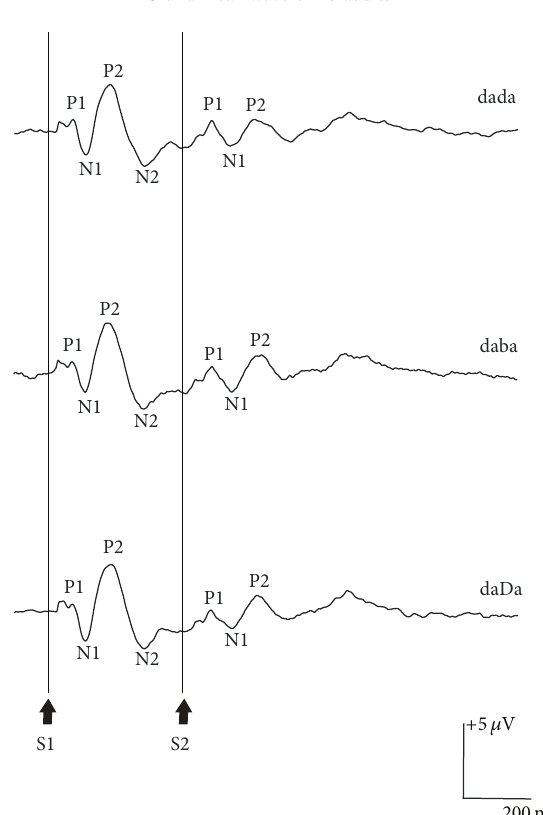
Figure 3: Grand mean waveform elicited to /dada/, /daba/, and /daDa/ at C3 for 10 adult participants. The onset of the S1 and S2 portion of the S1S2 stimuli is shown at the bottom of the graph. The P1, N1, P2, and N2 components of the obligatory cortical response elicited to S1 are indicated on the